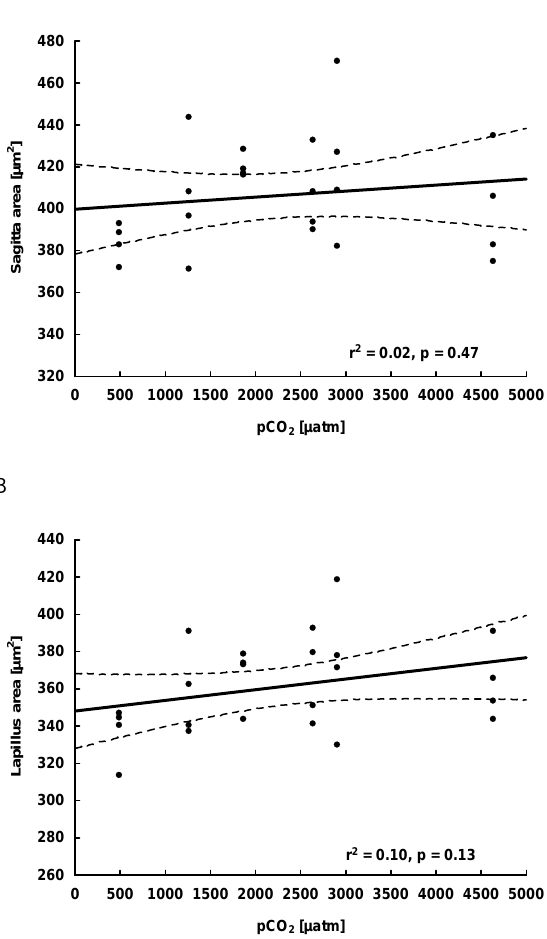
Fig. 4. (A) Sagitta area and (B) lapillus area of Atlantic herring lar- vae at hatch as a function of p CO 2 (4 replicates per treatment level). Figure 4. (A) Sagitta area and (B) lapillus area of Atlantic herring larvae at hatch as a function of Data points are mean values of 3 individual larvae (6 otoliths). The solid line shows the regression line, whereas the dashed lines repre- pCO 2 (4 replicates per treatment level). Data points are mean values of 3 individual larvae (6 otoliths). sent the 95% confidence The solid line shows the regression line, whereas the dashed lines represent the 95% confidence intervals.